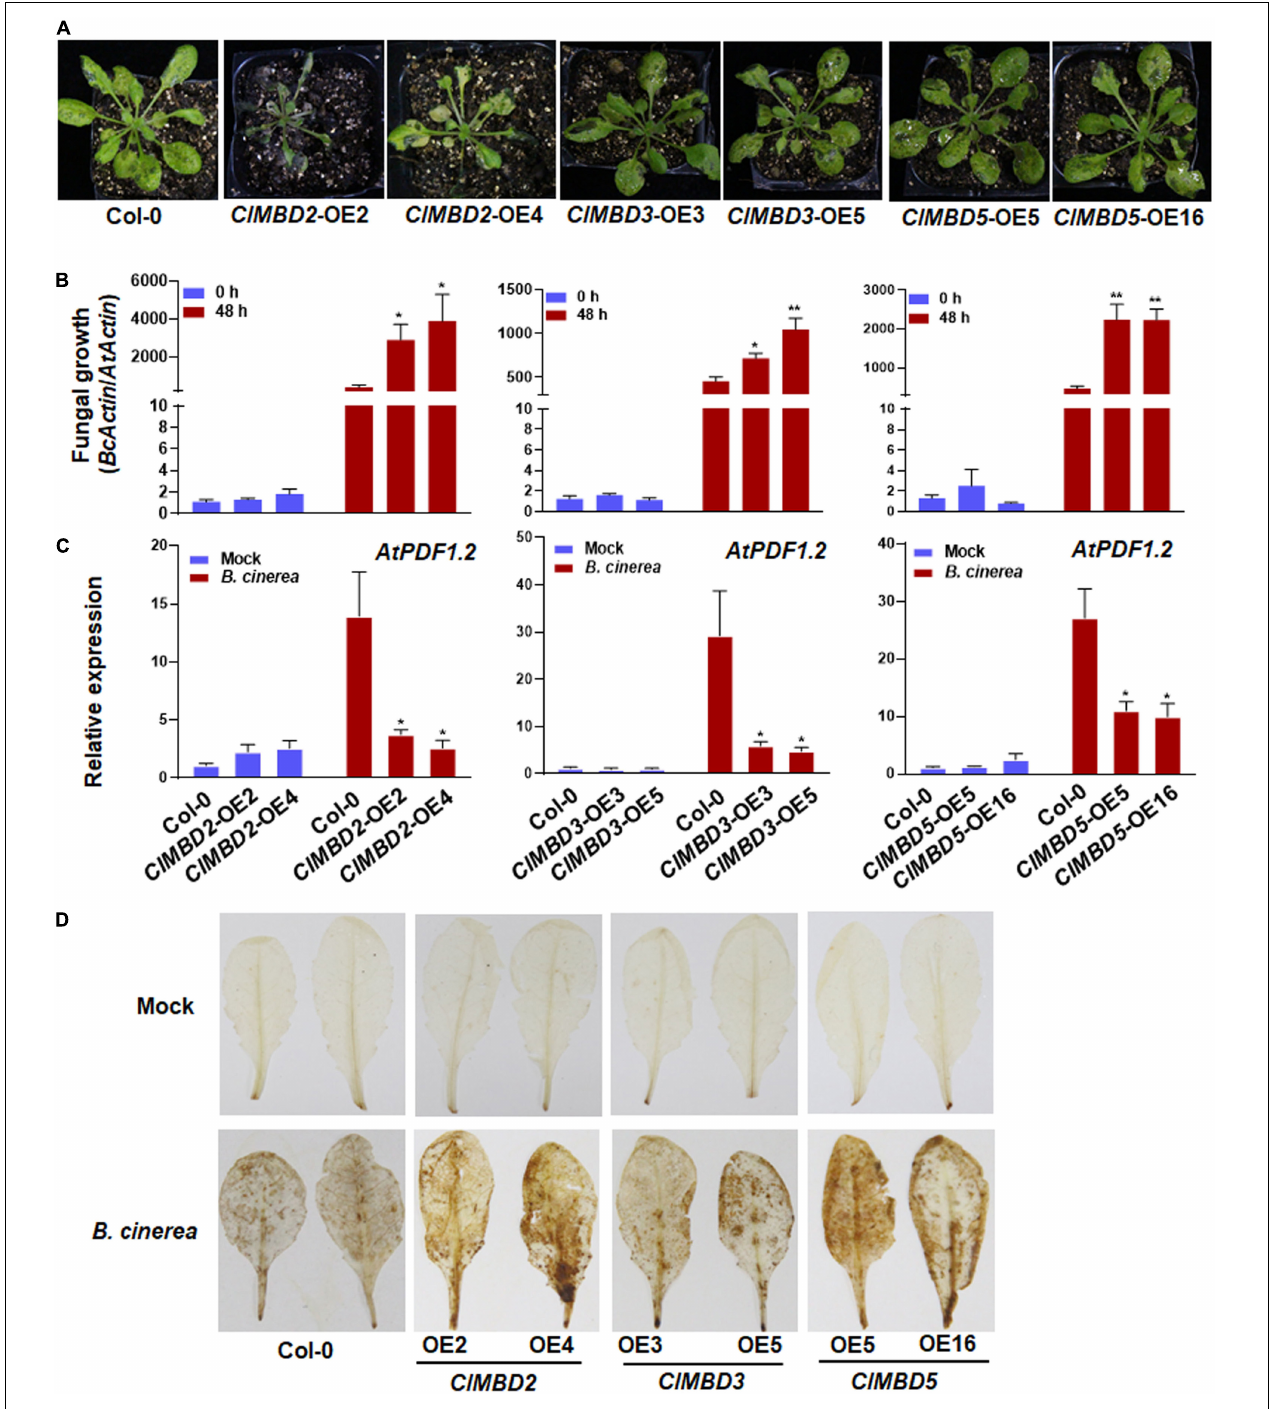
FIGURE 6 | ClMBD2 , ClMBD3 , and ClMBD5 negatively regulate resistance of the transgenic Arabidopsis plants against Botrytis cinerea . (A) Typical B. cinerea -caused disease on WT, ClMBD2 -OE, ClMBD3 -OE, and ClMBD5 -OE plants. Four-week-old plants were inoculated by foliar spraying with B. cinerea spore suspension (2 × 10 5 spores/mL) and photographed at 3 dpi. (B) In planta fungal growth in inoculated plants. Fungal growth was shown as ratios of the transcript level of B. cinerea BcActin to that of the Arabidopsis AtActin . (C) Relative expression of AtPDF1.2 in the mock- and B. cinerea -inoculated plants. qRT-RCR was performed using AtActin as an internal control to analyze the expression level of AtPDF1.2 . (D) Accumulation of H 2 O 2 in leaves of the in mock- and B. cinerea -inoculated plants, as revealed by DAB staining at 24 hpi. Experiments in (A,D) were repeated for three times with similar results, and results from one representative experiment are shown. Data presented in (B,C) are the means ± SE from three independent experiments and * or ** above the columns indicate significant differences at p < 0.05 or p < 0.01 levels (Student’s t -test), respectively, between the ClMBD2 / 3 / 5 -OE plants and WT plants at the same time point.